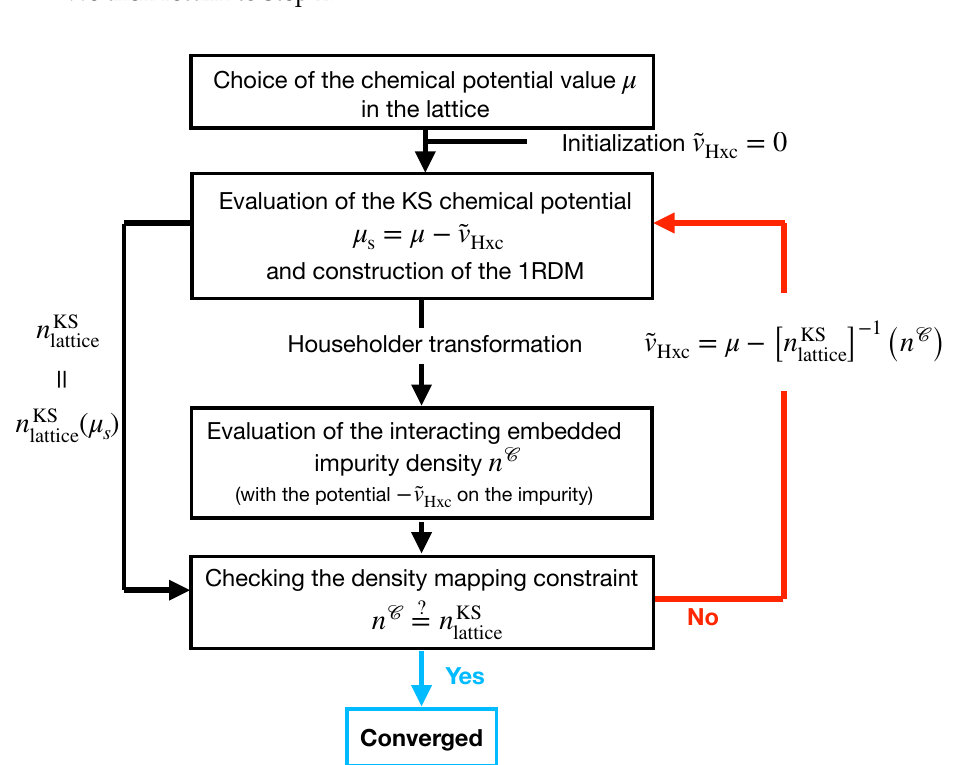
Figure 2. Schematics of the LPFET algorithm. The (one-electron reduced) density matrix of the KS lattice is referred to as the 1RDM. See text for further